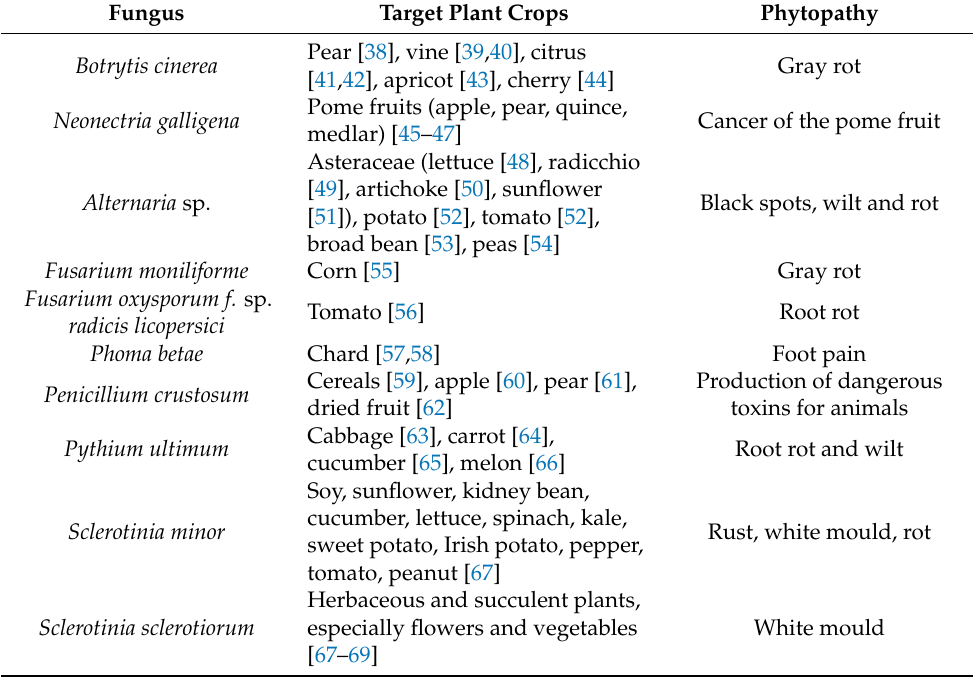
Gray rot Cancer of the pome fruit Black spots, wilt and rot Production of dangerous toxins for animals Root rot and wilt Rust, white mould, rot White